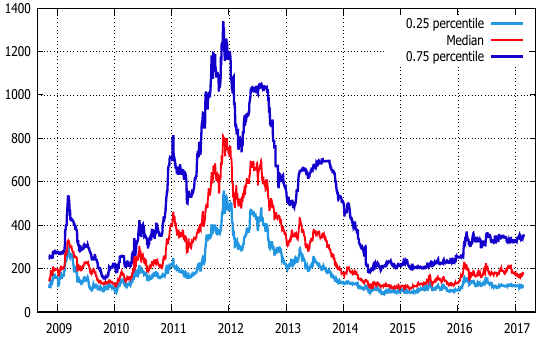
Figure 1. Banks CDS Spread. Plot of the median (red line) CDS spread; blue line indicates the 0.75, while the light blue line indicates 0.25 percentiles.